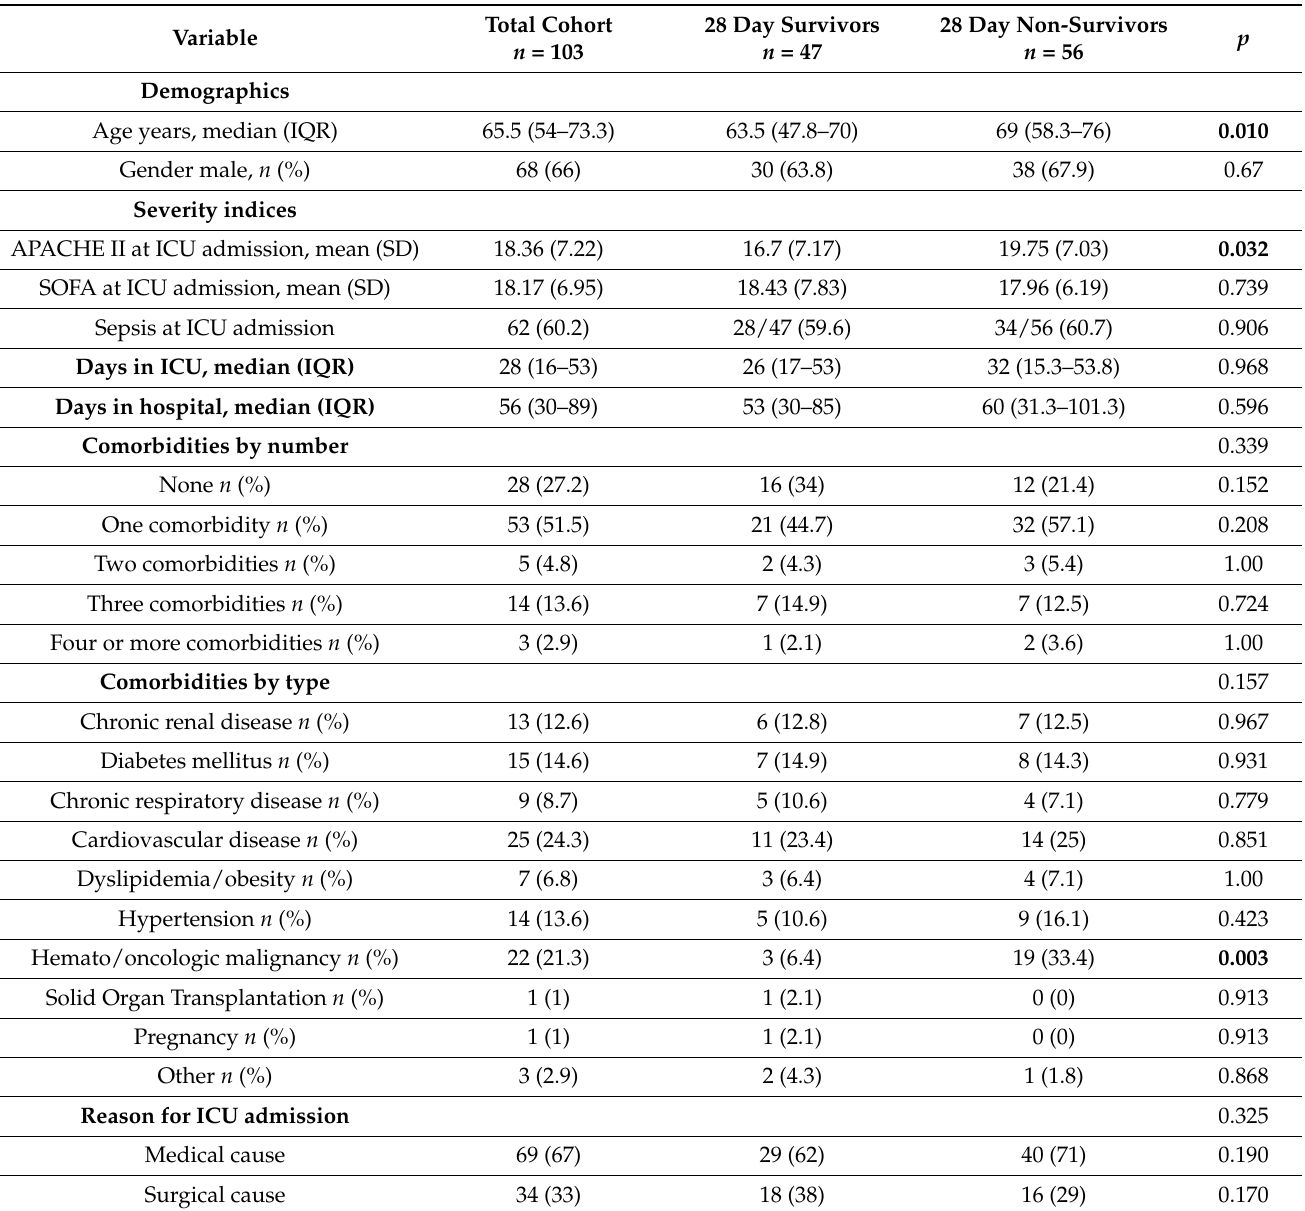
Table 1. Patients’ demographics and clinical